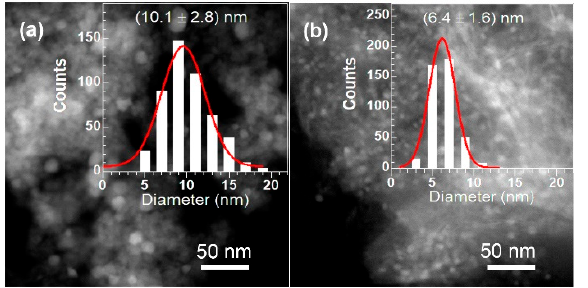
Figure 2. STEM images for ( a ) Ni/MgAl 2 O 4 -W and ( b ) Ni/MgAl 2 O 4 -E samples.